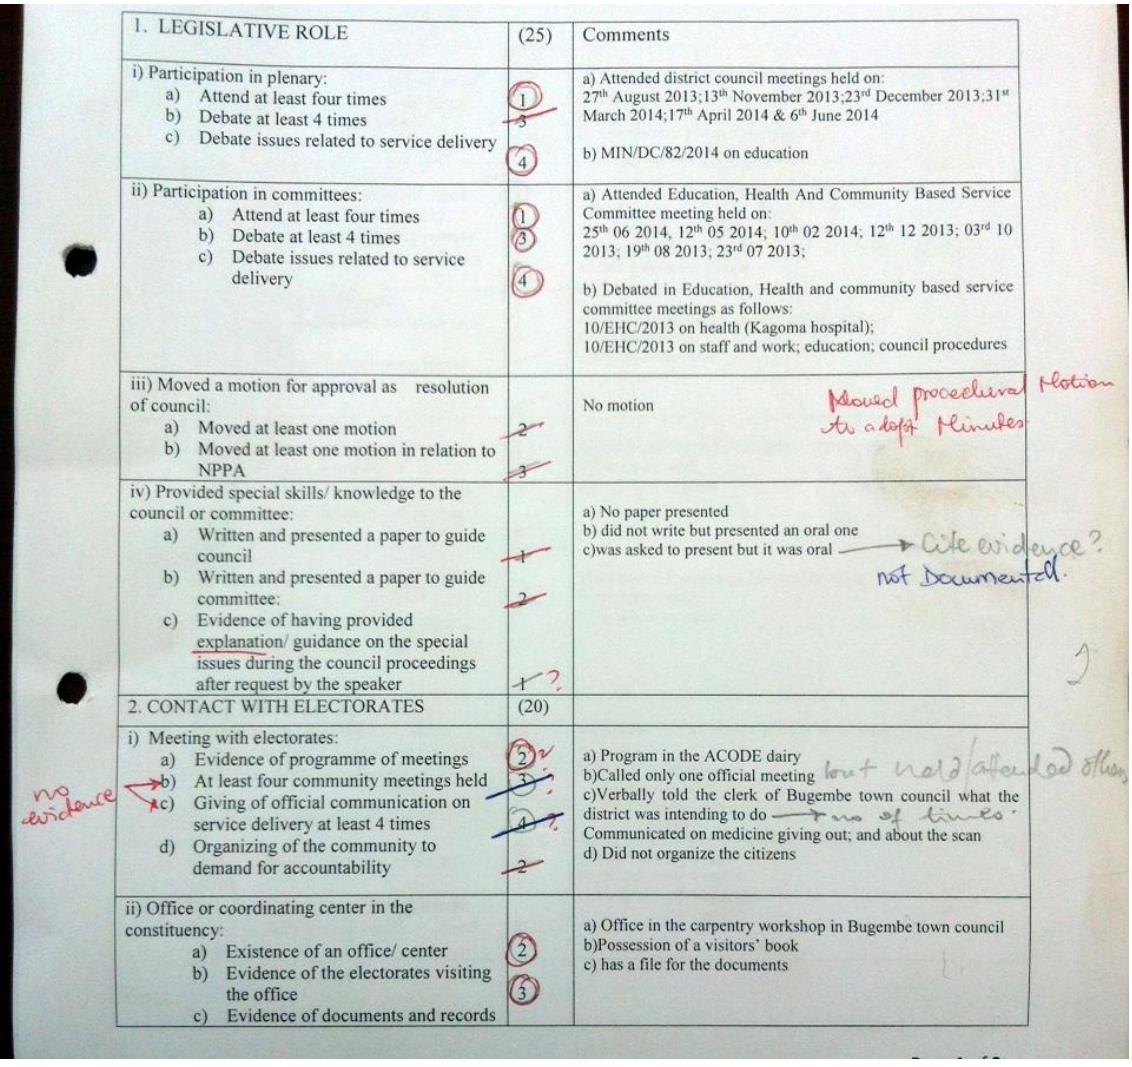
Figure 1: A snapshot of a councillor